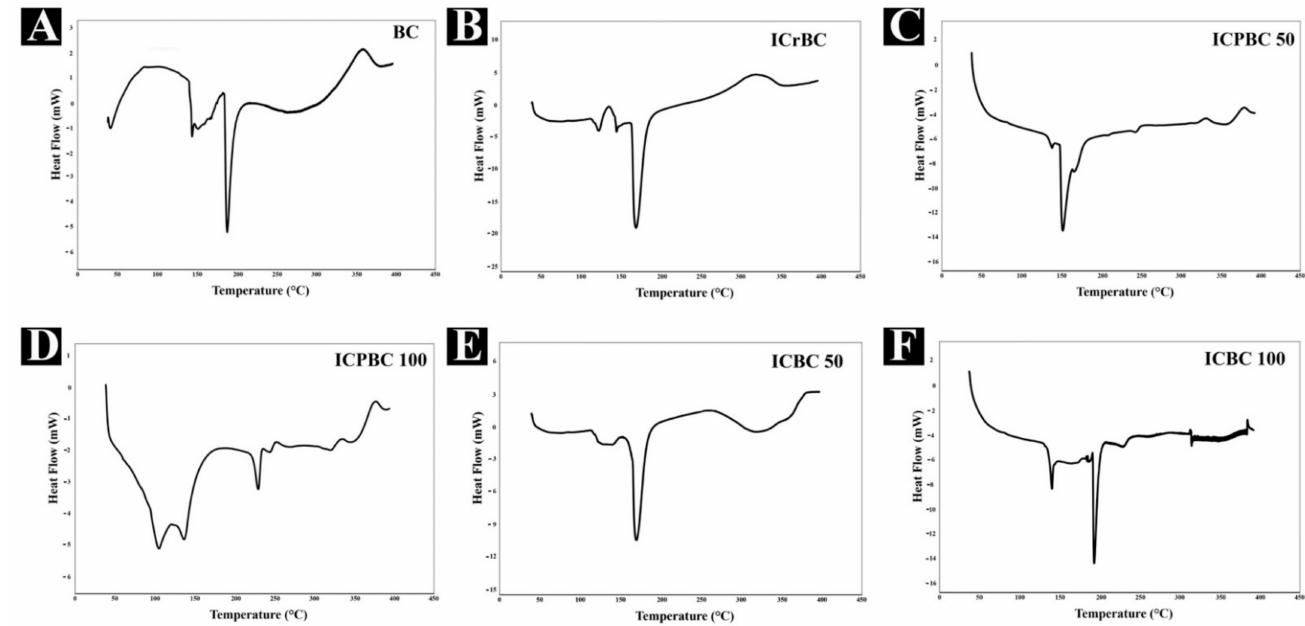
Figure 4. DSC curves of ( A ) Pure BC; ( B ) ICrBC membrane; ( C ) ICPBC 50 membrane; ( D ) ICPBC 100 membrane; ( E ) ICBC 50 membrane; ( F ) ICBC 100